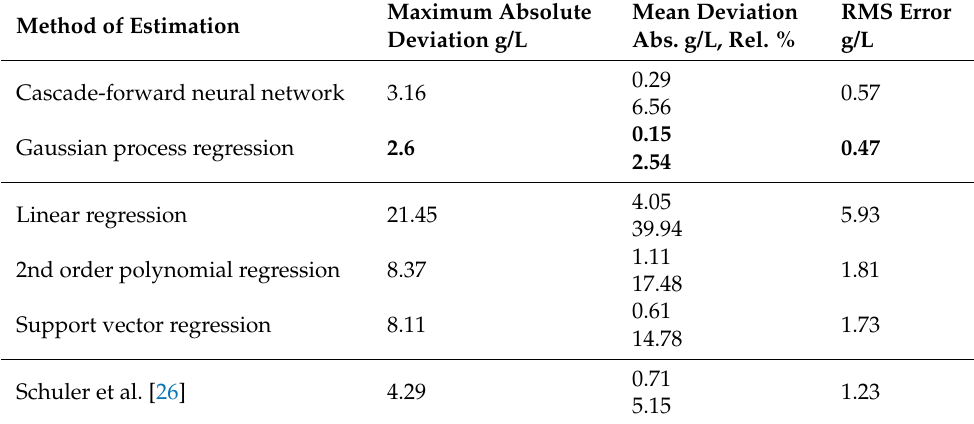
Table 3. Rating scores for various monosaccharide concentration estimation